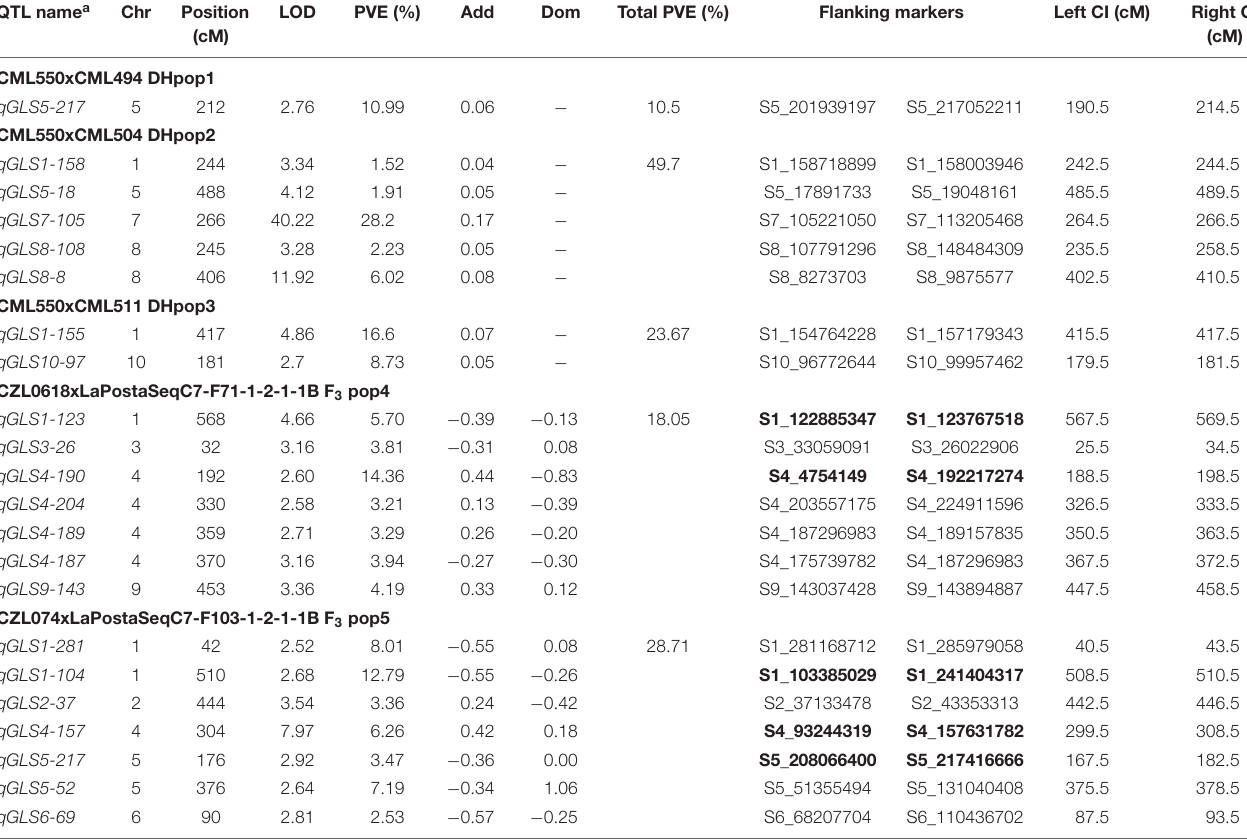
TABLE 2 | Detection of QTL associated with resistance to GLS, their physical positions, and genetic effects in three DH populations and two F 3